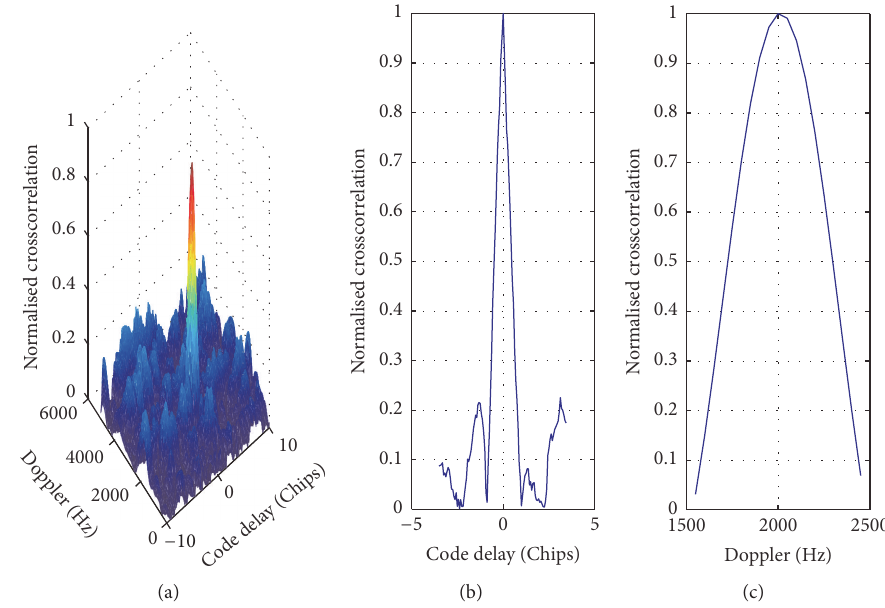
Figure 17: Correlation peaks after interference suppression by the proposed method for scenario